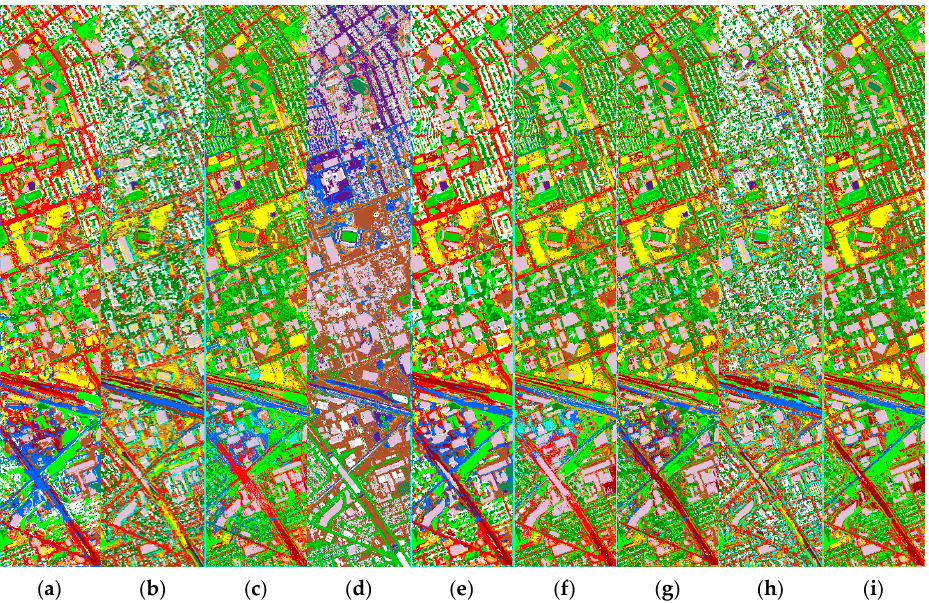
Figure 8. Classification maps obtained by different methods for the Houston dataset. ( a ) CNN-H; ( b ) CNN-L; ( c ) miniGCN-H; ( d ) miniGCN-L; ( e ) CCNet-HL; ( f ) CGNet-HL; ( g ) DCCGNet-H; ( h ) DCCGNet-L; ( i ) DCCG-HL.